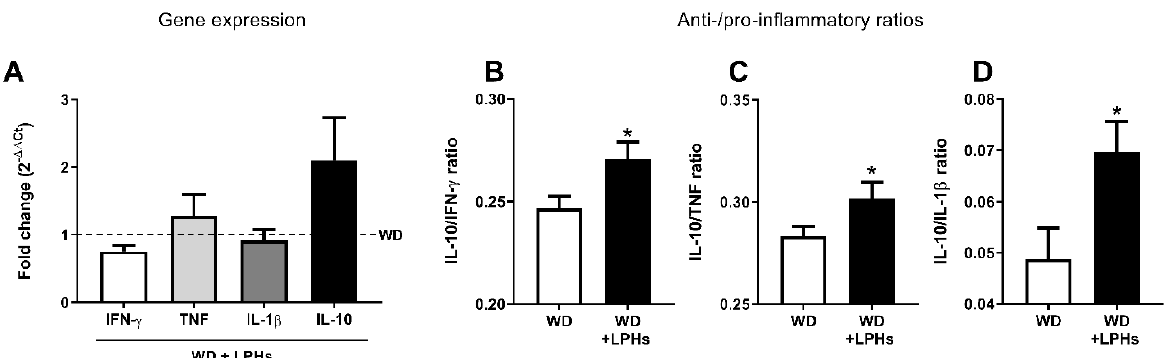
Figure 6. Liver inflammation. Relative gene expression of IFN- γ , TNF, IL-1 β , and IL-10 in the liver of mice after 12 weeks of treatment with LPHs ( A ). The pointed line represents WD group, while the bars represent the LPHs effects with respect to WD group. Ratios between IL-10 and pro-inflammatory cytokines IFN- γ ( B ), TNF ( C ), IL-1 β ( D ) expression ( n = 10). Results are represented as the mean and standard error of the mean of each group. * p ≤ 0.05 with respect to the WD group. IFN- γ , interferon- γ ; IL, interleukin; TNF, tumor necrosis factor; WD, western diet group; WD+LPHs, western diet + lupin protein hydrolysates group.